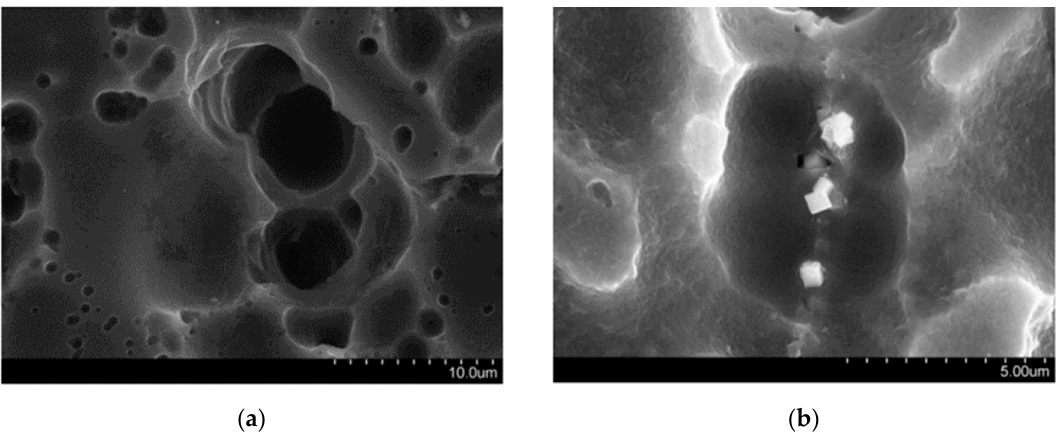
Figure 10. SEM images of corrosion pits ( a ) without visible Y-rich phases and ( b ) with visible Y-rich phases.